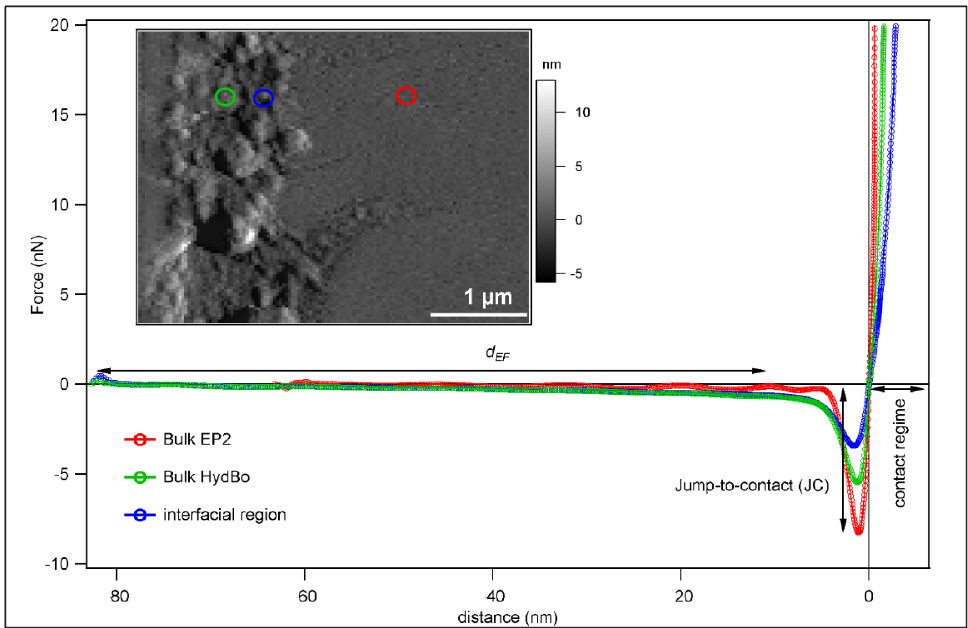
Figure 3. Averaged force-distance curves from amplitude dependence force spectroscopy (ADFS) measurements on point locations shown in the inset image (topography). See text for details.